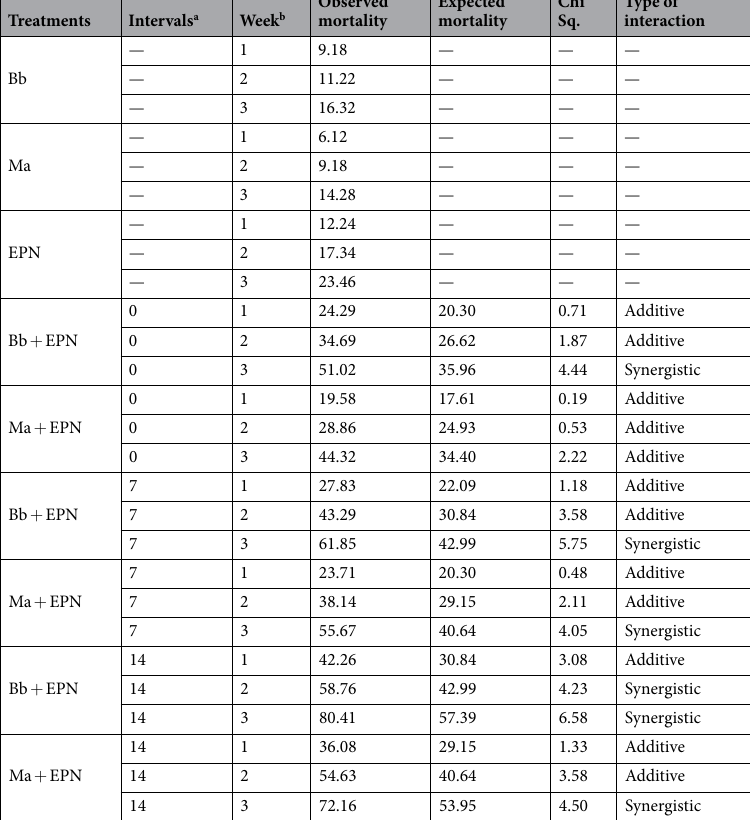
Table 2. Mean mortality (% ± SE) of 4 th instar larvae of Rhynchophorus ferrugineus treated with Beauveria bassiana, Metarhizium anisopliae and Heterorhabditis bacteriophora. B. bassiana and M. anisopliae were used each @ 1 × 10 6 conidia ml − 1 and H. bacteriophora was applied @ 100 IJs ml − 1 (Bb: Beauveria bassiana , Ma: Metarhizium anisopliae , EPN: Heterorhabditis bacteriophora , IJs: Infective Juveniles). a Intervals between the application of EPFs and EPNs. b Week after fungal